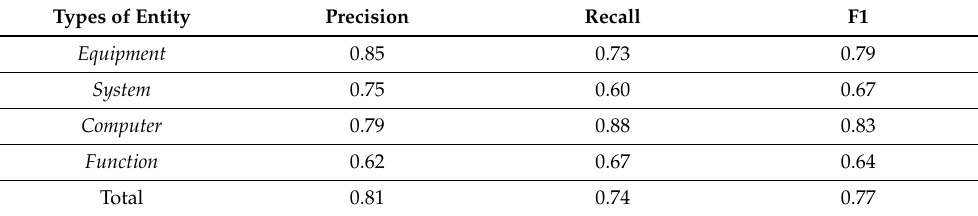
Table 2. The results of only using embeddings from word2vec: total _ embedding i = [ WORD i ] .